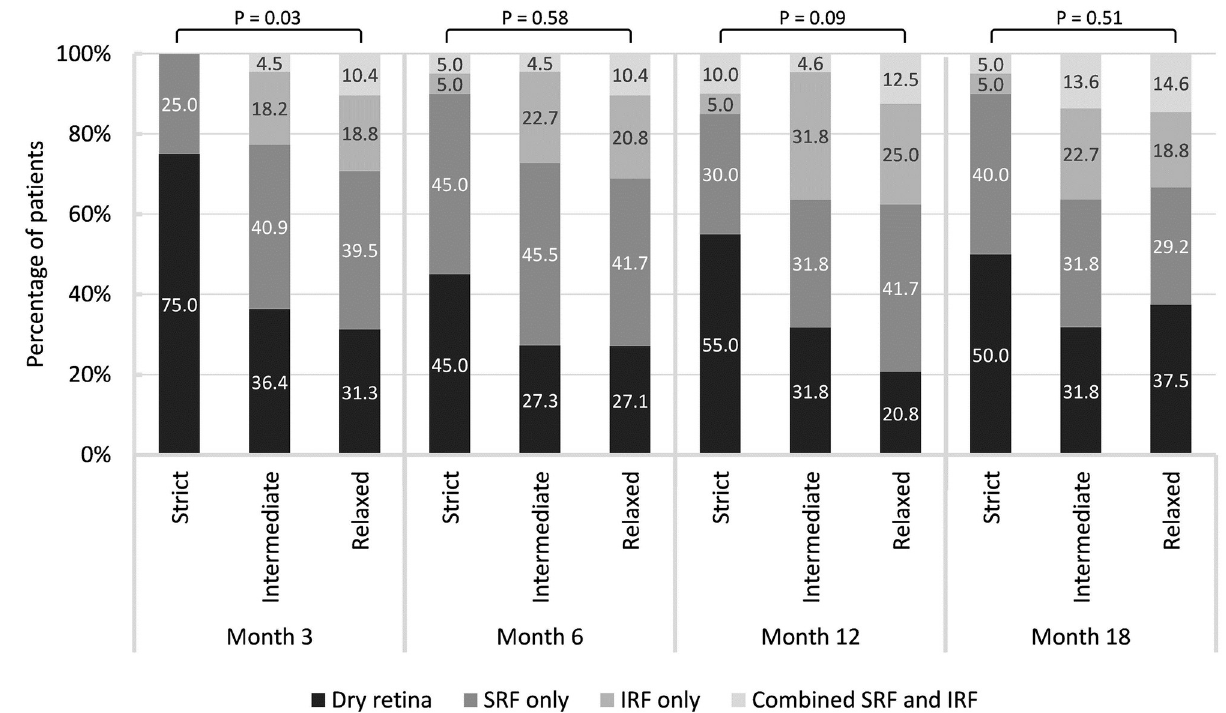
Fig 1. Retinal fluid components among strict, intermediate, and relaxed group at various time points.